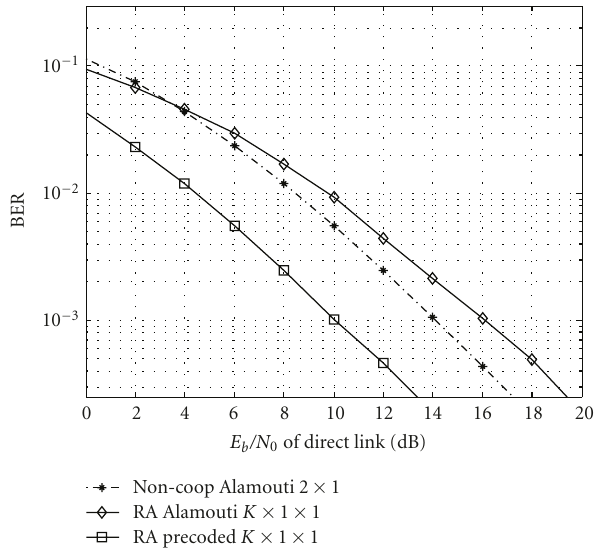
Figure 11: BER of cooperative systems with 1 antenna per relay and of reference systems for Scenario 2.